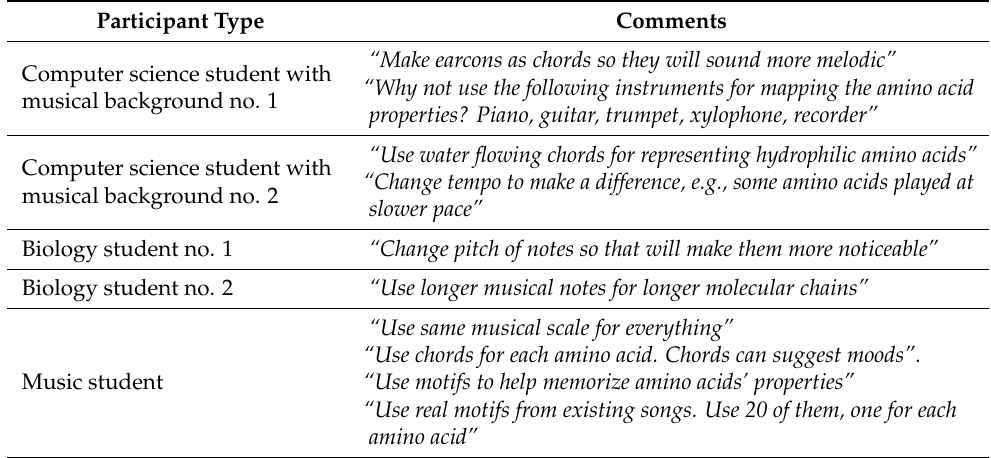
Table 4. Comments made by the participants suggesting new sonification